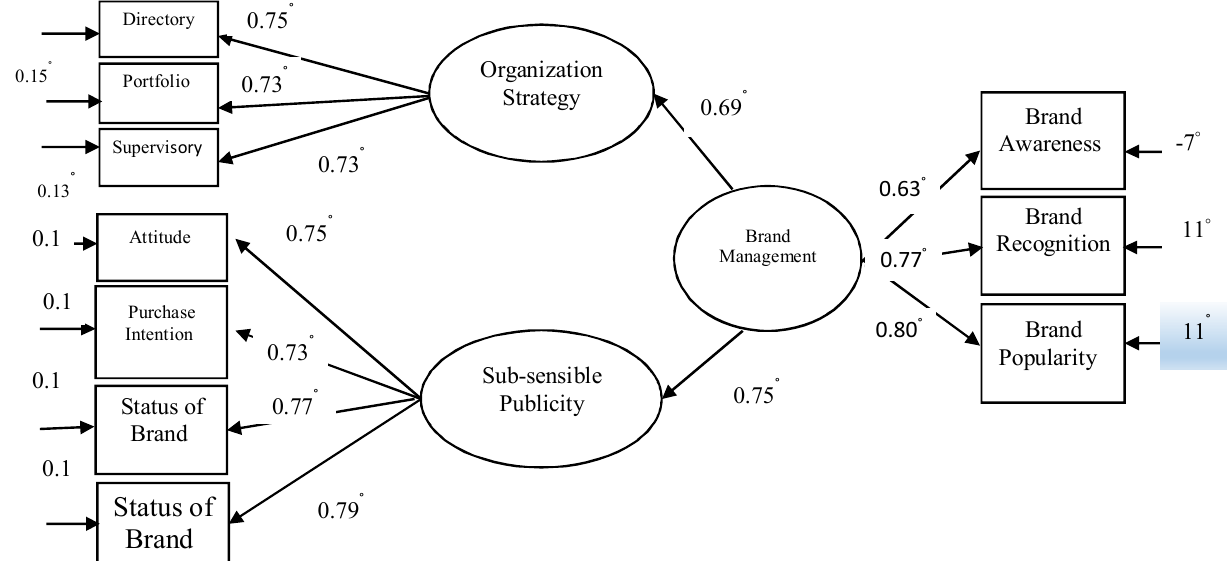
Fig. 3. Conceptual Investigation LAZERL Software represents meaningfulness of related coefficients) o